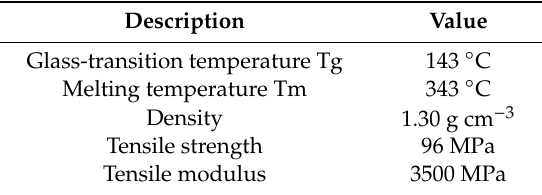
Table 2. The material properties of the polyetheretherketone (PEEK)